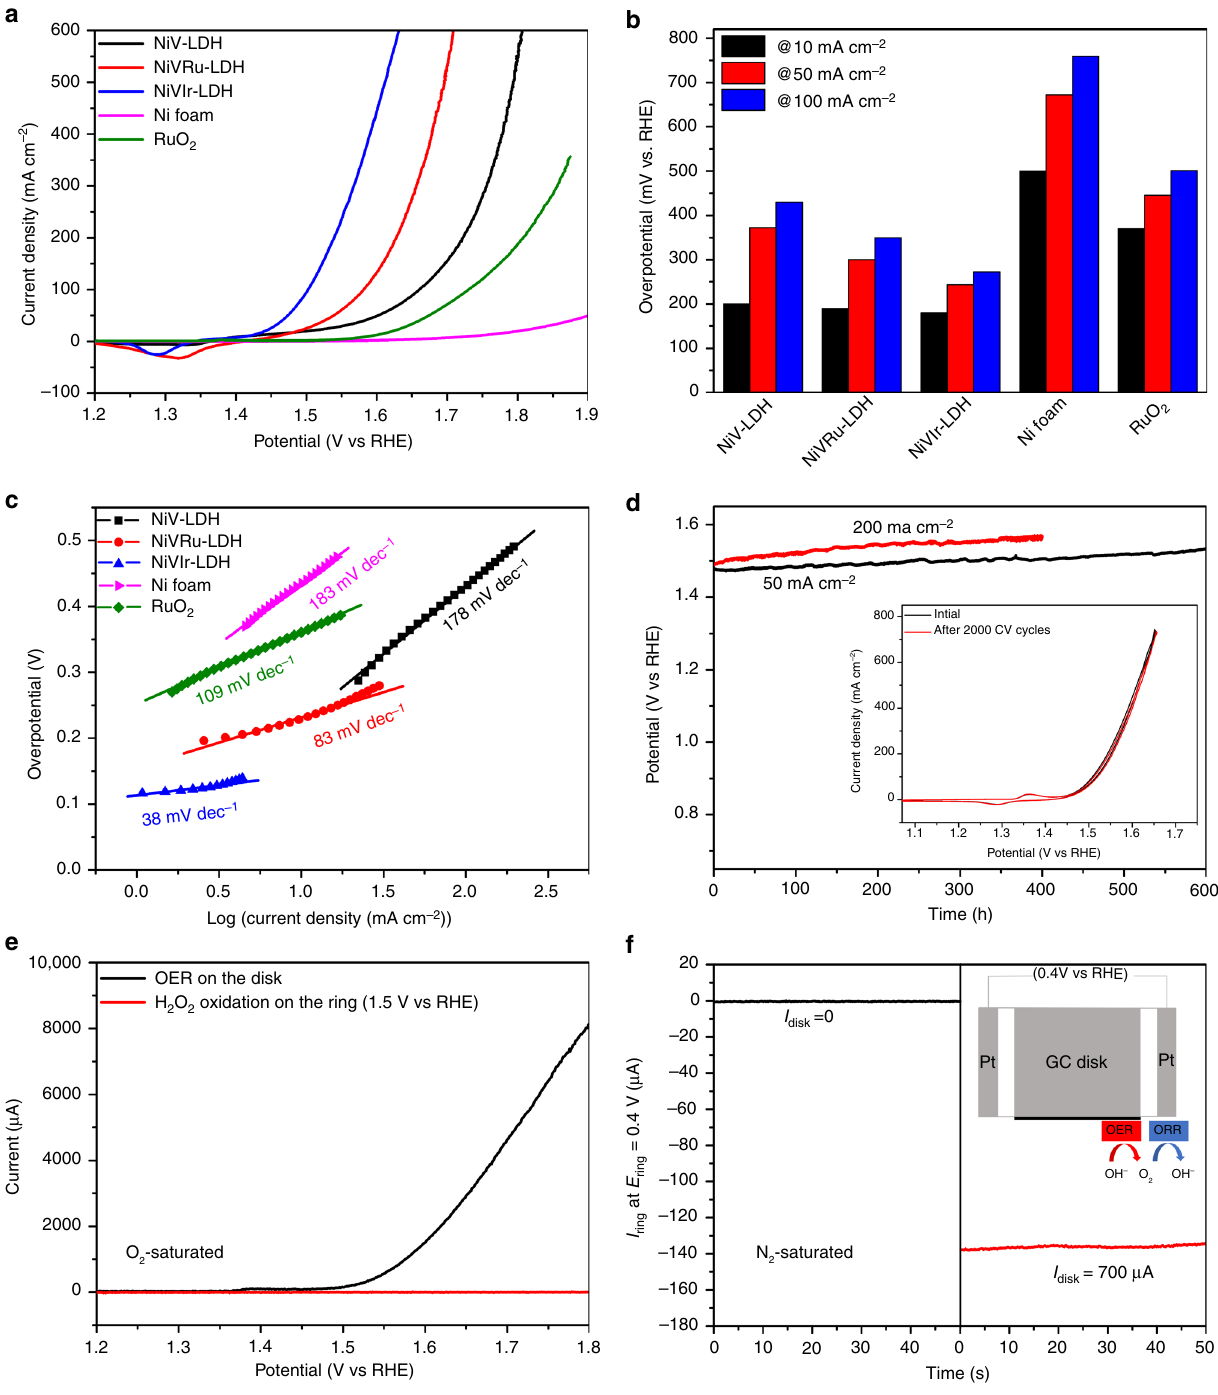
Fig. 5 OER polarization curves, Tafel plots, and long-term stability. a OER polarization curves, b the overpotentials at 10, 50, and 100 mA cm − 2 , and c the corresponding Tafel plots of the as-obtained NiV-LDH, NiVRu-LDH, NiVIr-LDH, Ni foam, and RuO 2 . d The chronopotentiometric curves of NiVIr-LDH for the OER test at 50 and 200 mA cm − 2 . Inset: polarization curves of NiVIr-LDH for the durability test after 2000 CV cycles. e Detection of H 2 O 2 generated using RRDE measurement. The ring current of NiVIr-LDH on a RRDE (1500r.p.m.) in O 2 -saturated 1 M KOH solution (ring potential: 1.50 V). f The ring current of NiVIr-LDH on a RRDE (1500 r.p.m.) in N 2 -saturated 1 M KOH solution (ring potential: 0.40